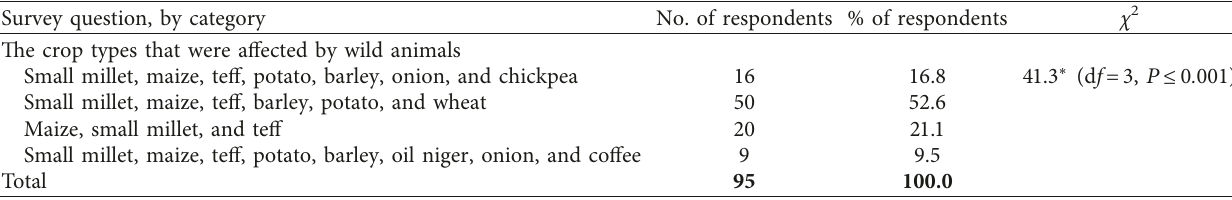
Table 3: Main crop type attacked by wild animals according to the respondents’ perceptions. Survey question, by